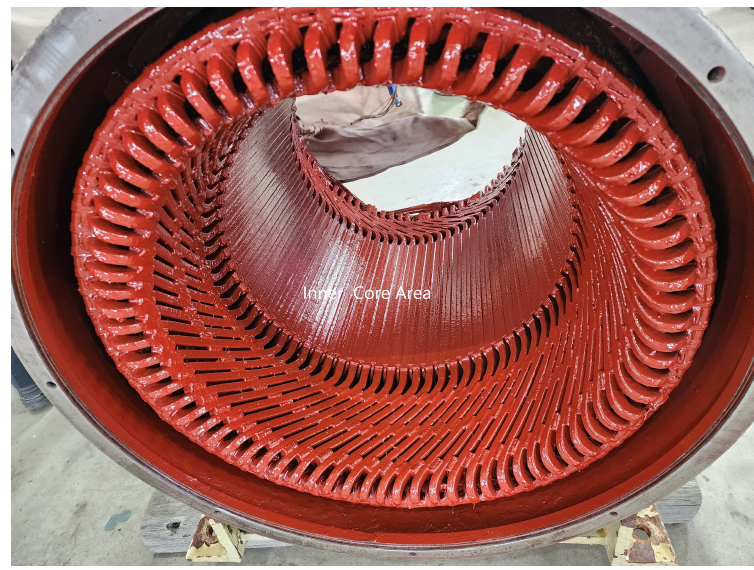
Figure 5. Motor Stator Inner Core Area with